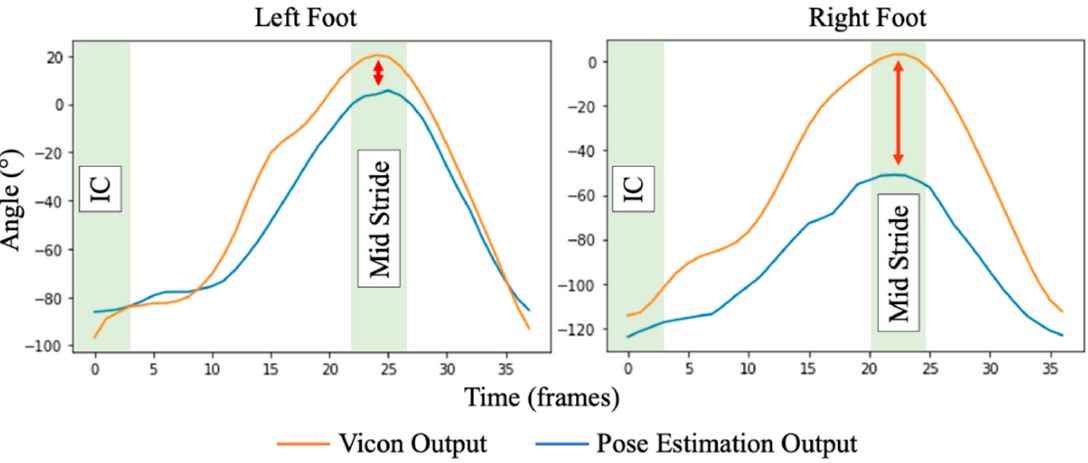
Figure 7. An illustration of the foot angle of an average stride within the dataset between left and right feet. Here, there is a significant deviation between left and right feet. In the left foot, signals are closely associated with surrounding initial contact events and begin to slightly deviate during the mid-stride. Alternatively, the right foot demonstrates a further deviance between pose estimation and 3D motion tracking signals, exacerbated during the mid-stride.